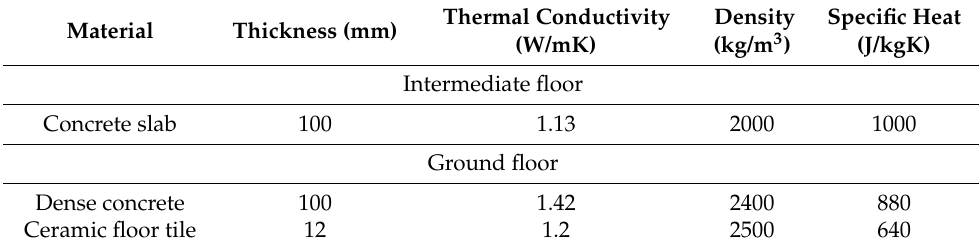
Table 3. Thermophysical properties of the